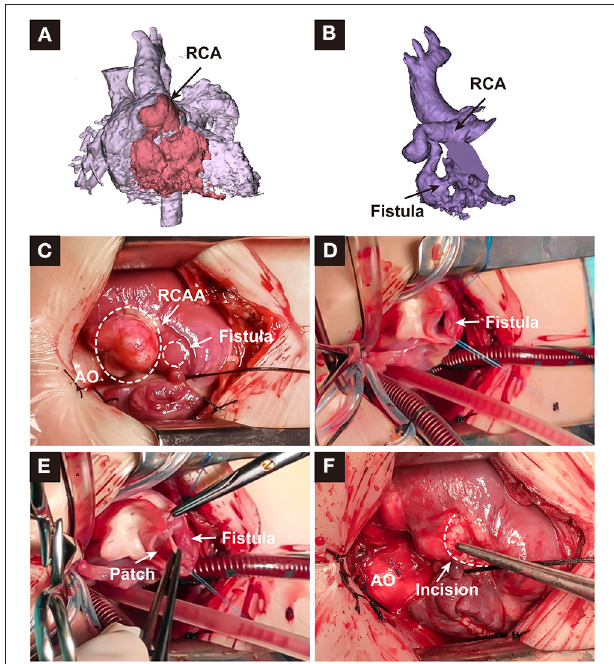
FIGURE 2 | (A,B) depicted the reconstructed image of the heart and dilated right coronary artery. (C–F) depicted the surgical repair process. RCA, right coronary artery; RCAA, right coronary artery aneurysm; AO, aorta.